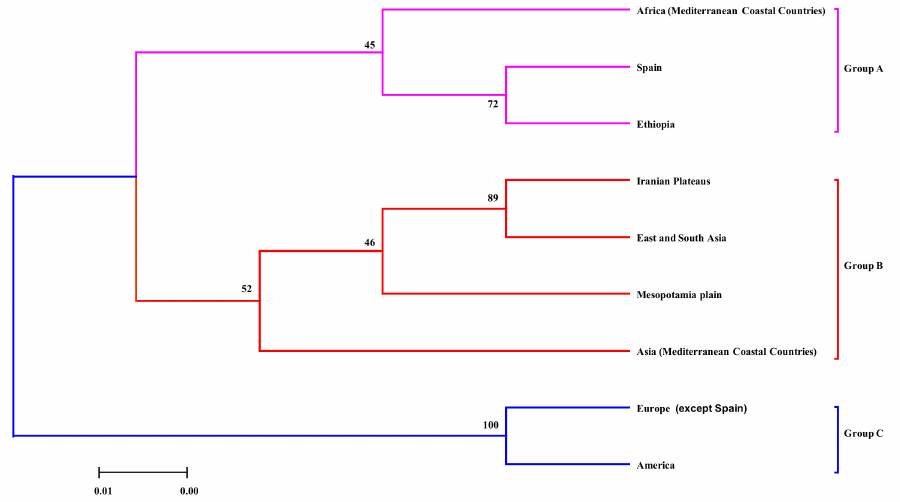
Figure 3. Clusters of 410 faba bean accessions based on distribution route and geographical origin by 3000 SNP